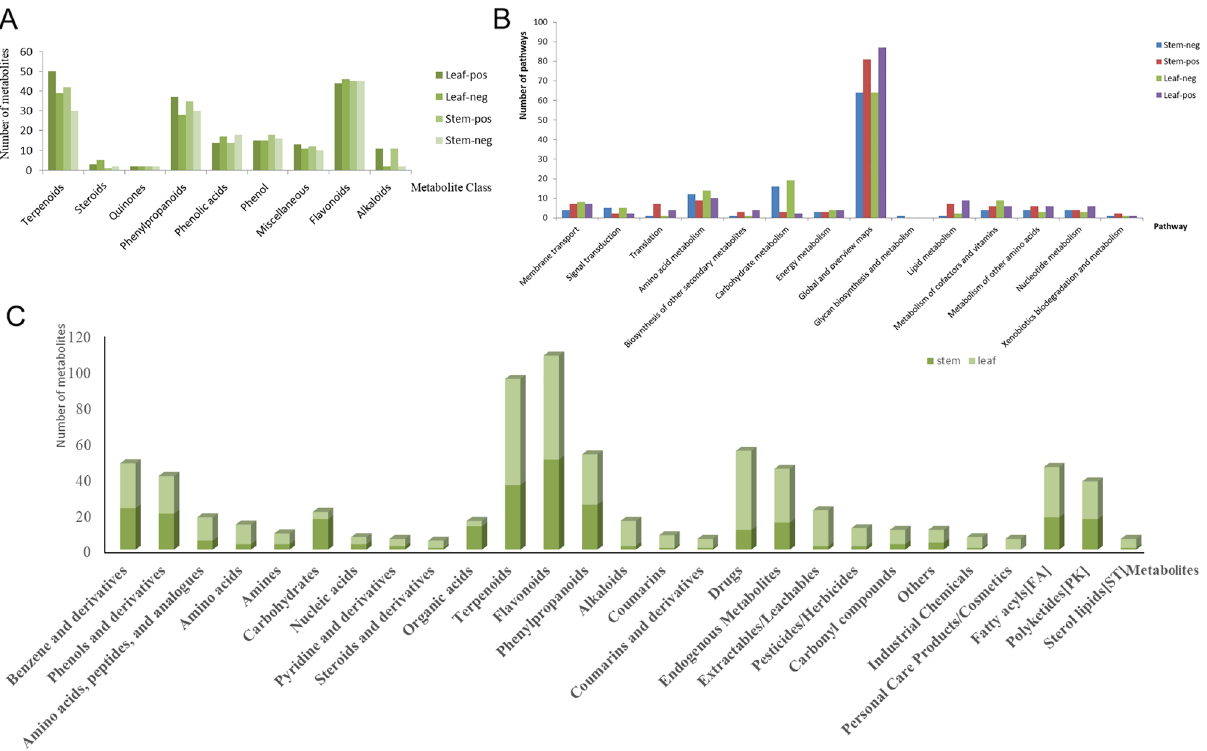
Figure 4. (A) Metabolite classification bar chart in BGI library. (B) Bar chart of metabolite KEGG function annotation. (C) Bar chart of metabolite